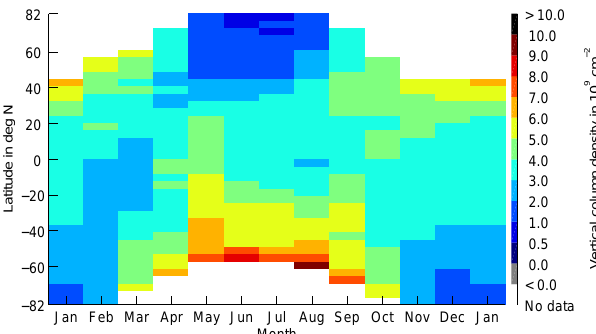
Figure 18. Seasonal variation of the vertical Na column densities (VCDs).